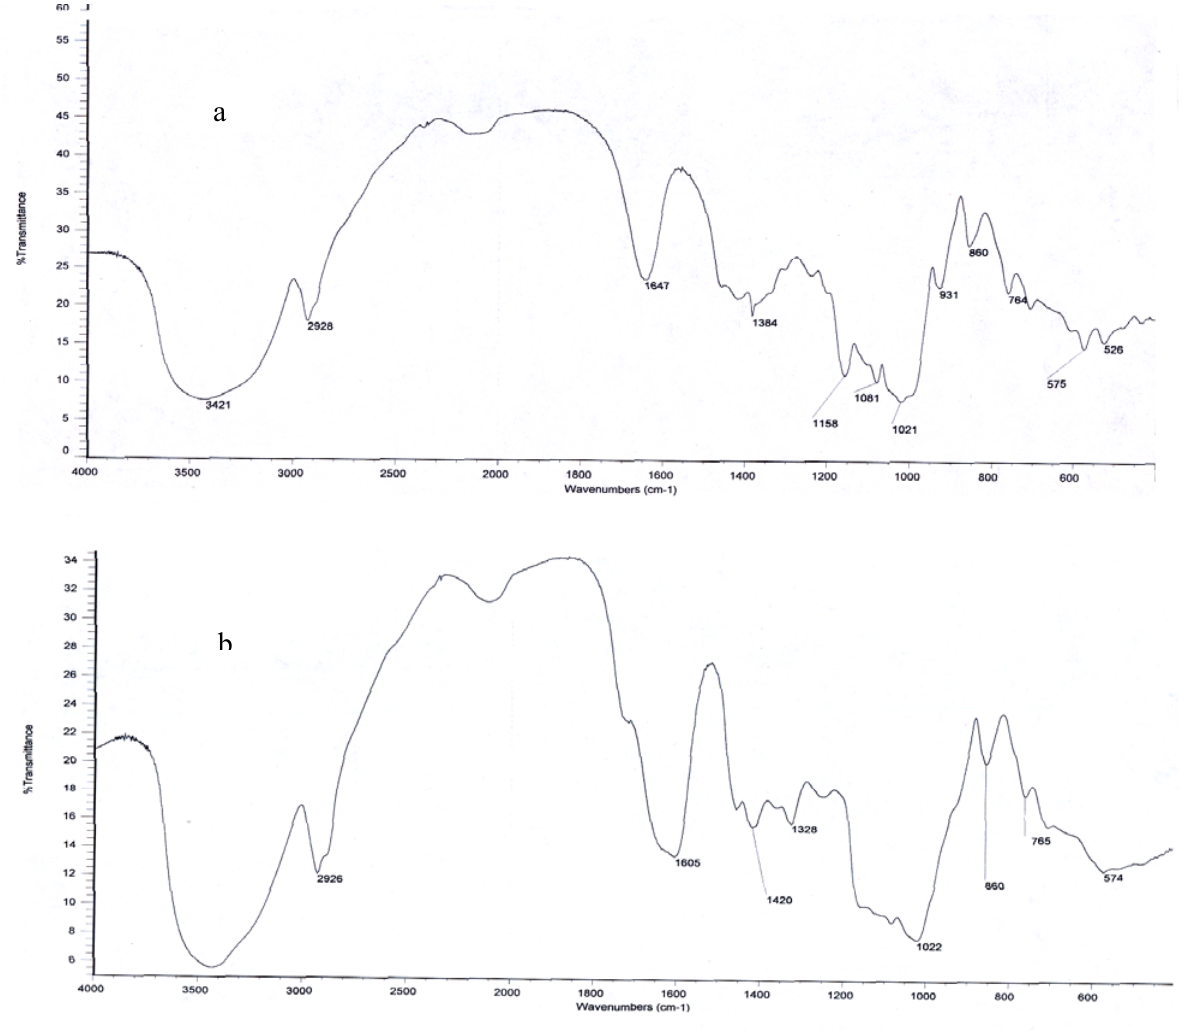
Figure 2. FTIR spectra of (a) soluble starch; (b)